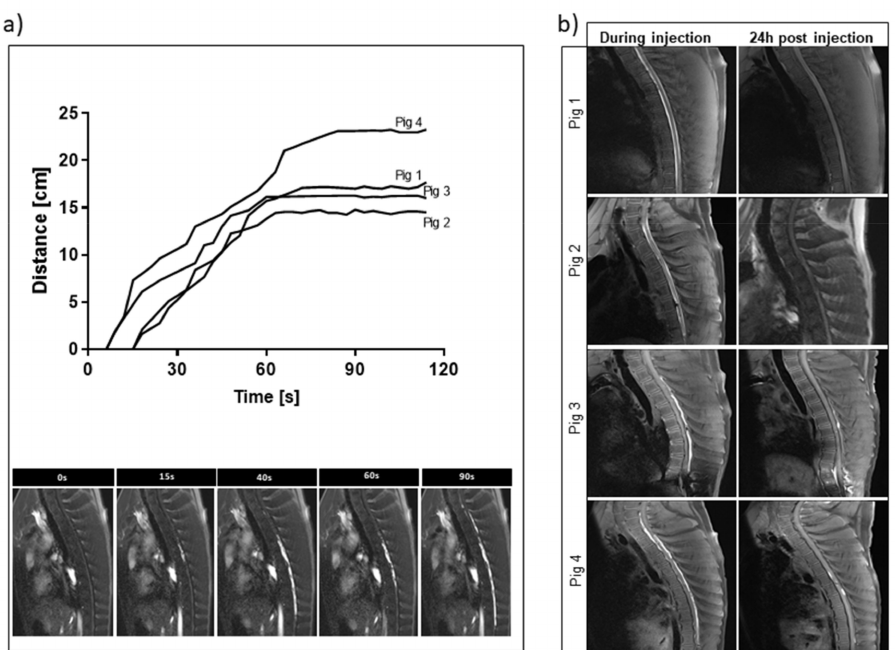
Figure 4. MRI-guided intrathecal transplantation of LVM/Mn2+ hydrogels. ( a ) Real-time analysis of the distance spreading of the hydrogel. ( b ) Comparison of the T1weighted MRI scans during and 24 h after injection.